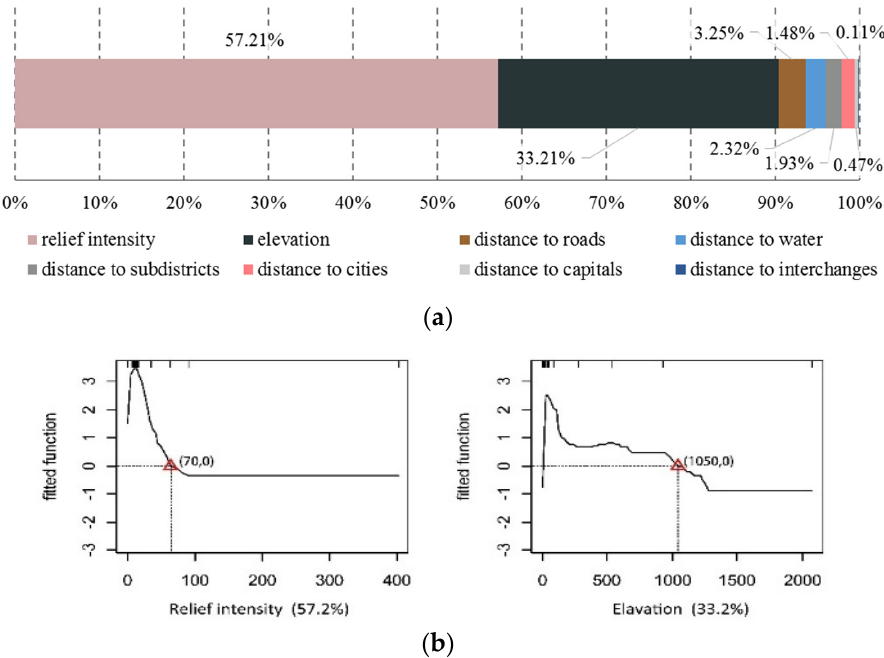
Figure 12. Factor contribution ranking and marginal effect of PS–LS. ( a ) Contribution degree of factors; ( b ) marginal effect of factor with a contribution degree over 10%.